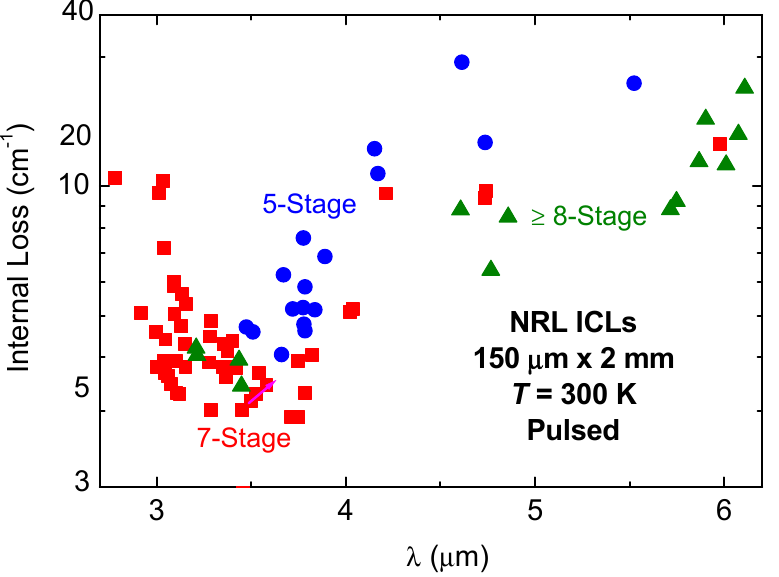
Figure 7. Internal loss vs. wavelength at 300 K as estimated from the pulsed slope efficiencies, for NRL broad area ICLs with 5 (blue), 7 (red), and ≥ \8 (green) stages, assuming 80% internal efficiency per stage.